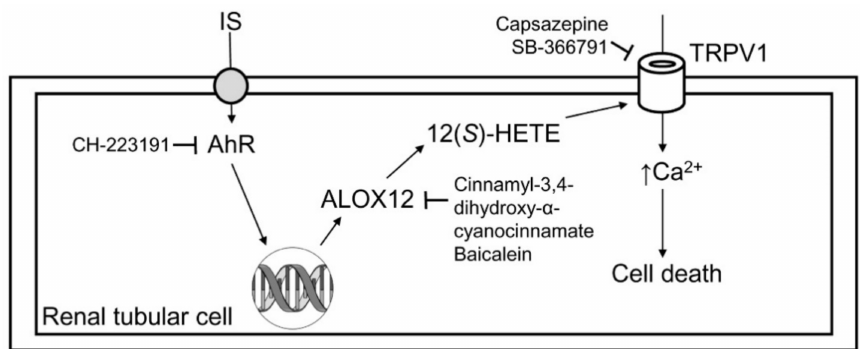
Figure 6. Schematic diagram showing how indoxyl sulfate induced cytotoxicity in tubular cells. After the uptake of indoxyl sulfate (IS), IS then induced tubular cell damage via AhR activation, and this e ff ect could be abrogated by the AhR inhibitor CH-223191. AhR upregulated ALOX12 expression and cellular 12( S )-HETE synthesis. The blockade of ALOX12 also attenuated IS-mediated tubular damage. Excess formation of 12( S )-HETE overstimulated TRPV1 to induce cell damage, and this e ff ect could be attenuated after TRPV1 inhibition by capsazepine and